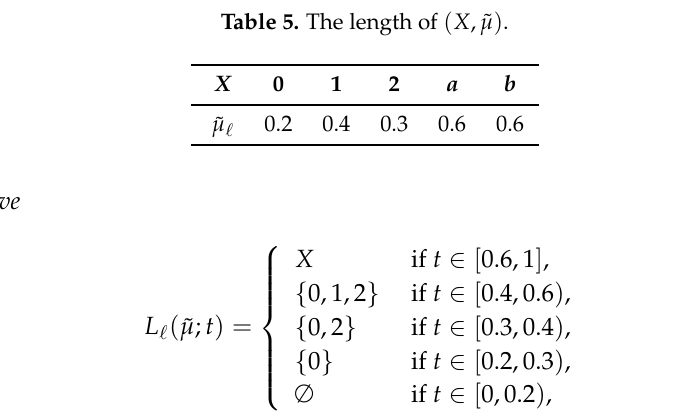
Table 5. The length of ( X , ˜ µ )